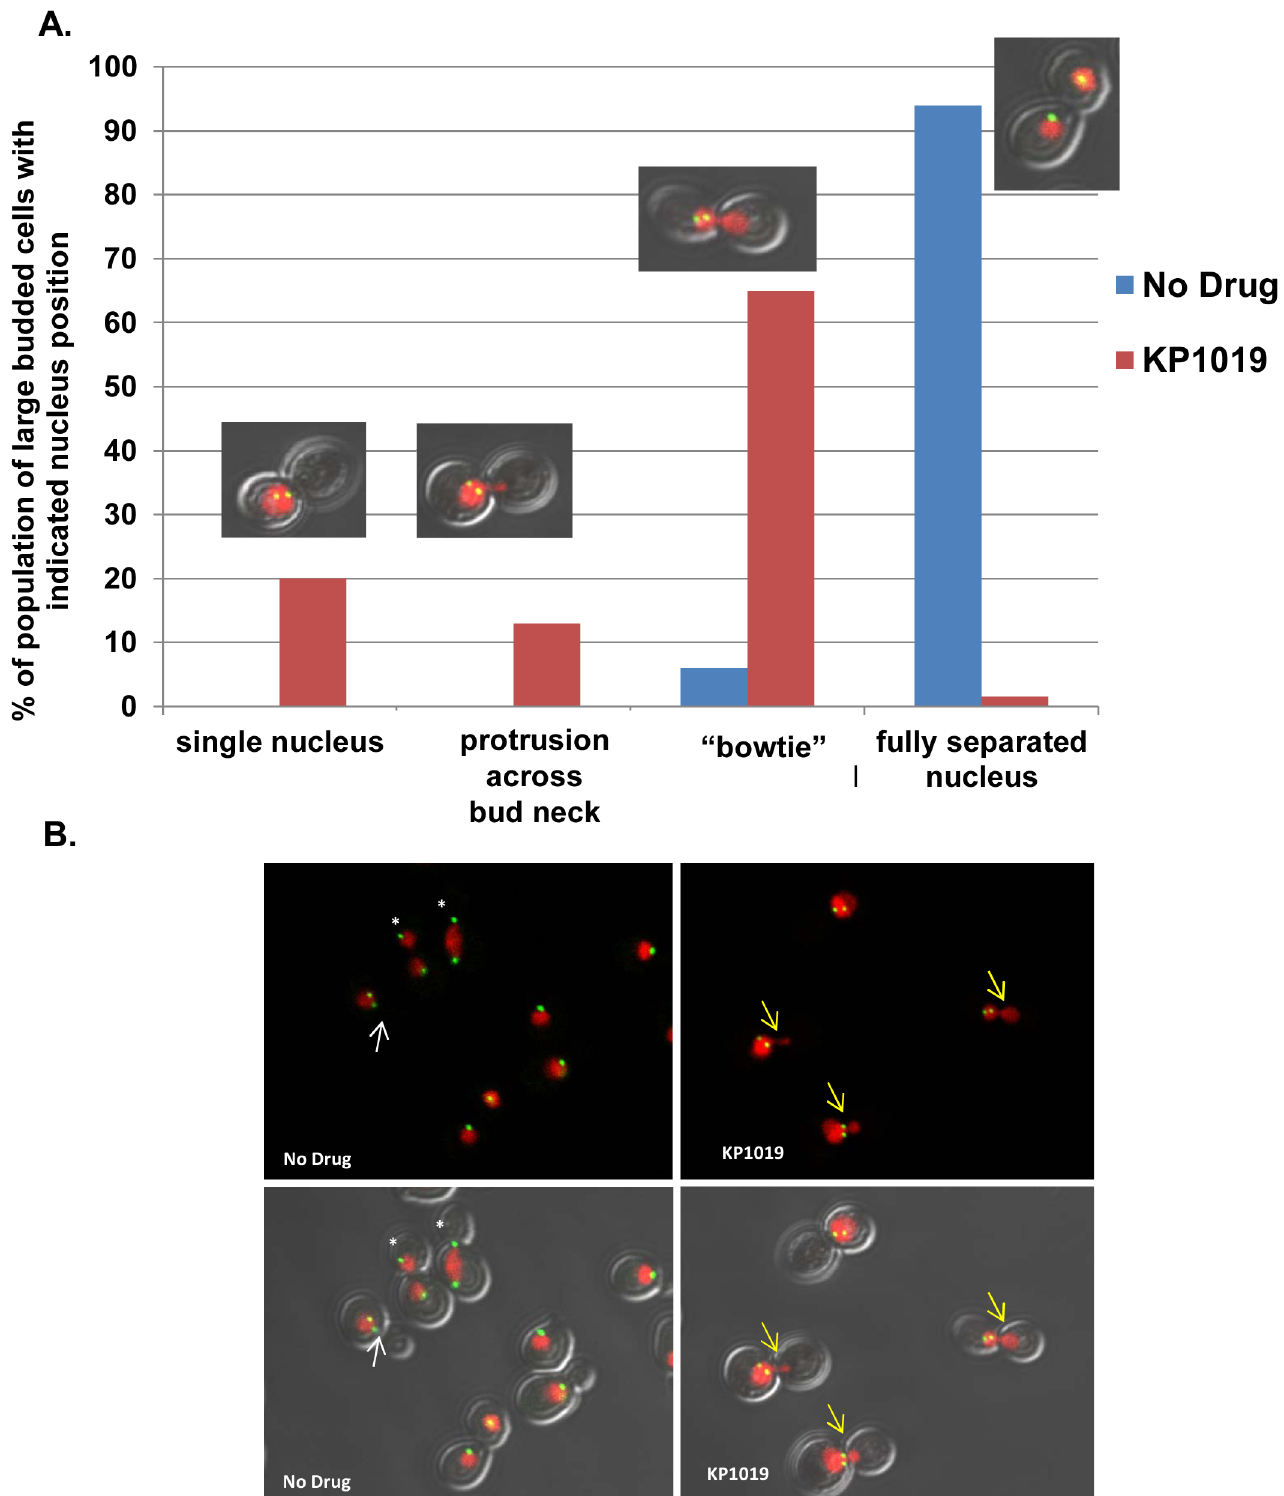
Fig 5. Nuclear Morphology in KP1019 treated cells. A. Early log phase wild-type yeast were treated with 80ug/ml KP1019 for three hours and nuclear morphology was determined as described in Materials and Methods. Large budded cells were scored on the position of the nucleus relative to the bud neck. Categories are indicated on the X-axis, and include a single nuclei positioned near the bud neck and not migrating across the bud neck (single nucleus),